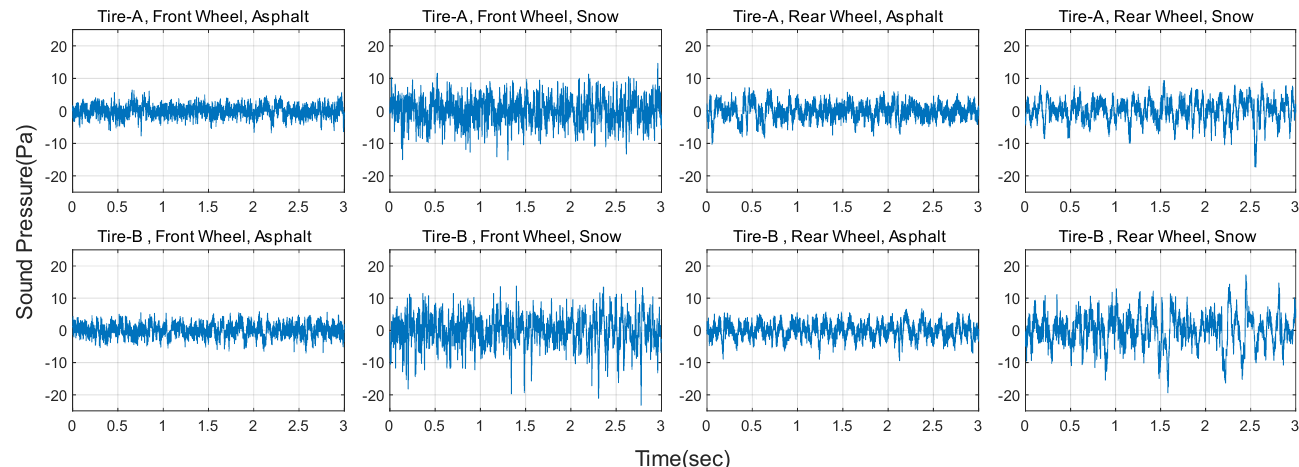
Figure 7. Time history of TPIN signals measured by microphones.